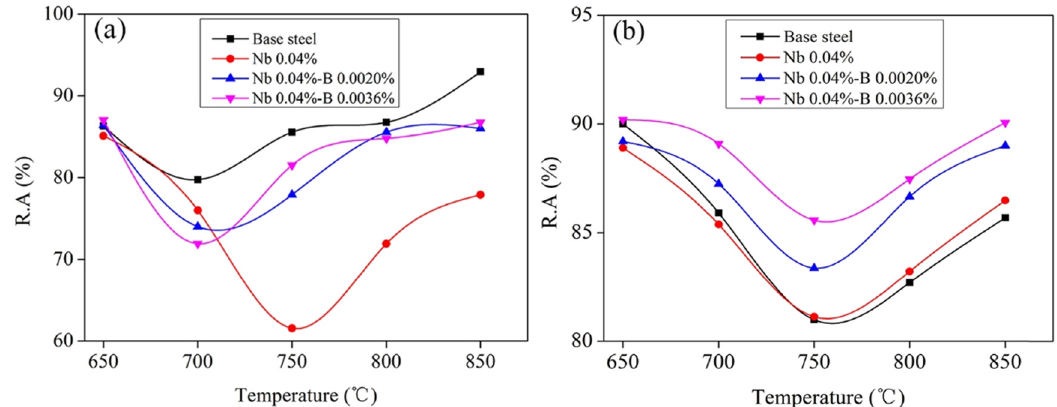
Figure 2: Hot ductility curves with a strain rate of 0.005 s − 1 ( a ) and 0.5 s − 1 ( b ) of the test